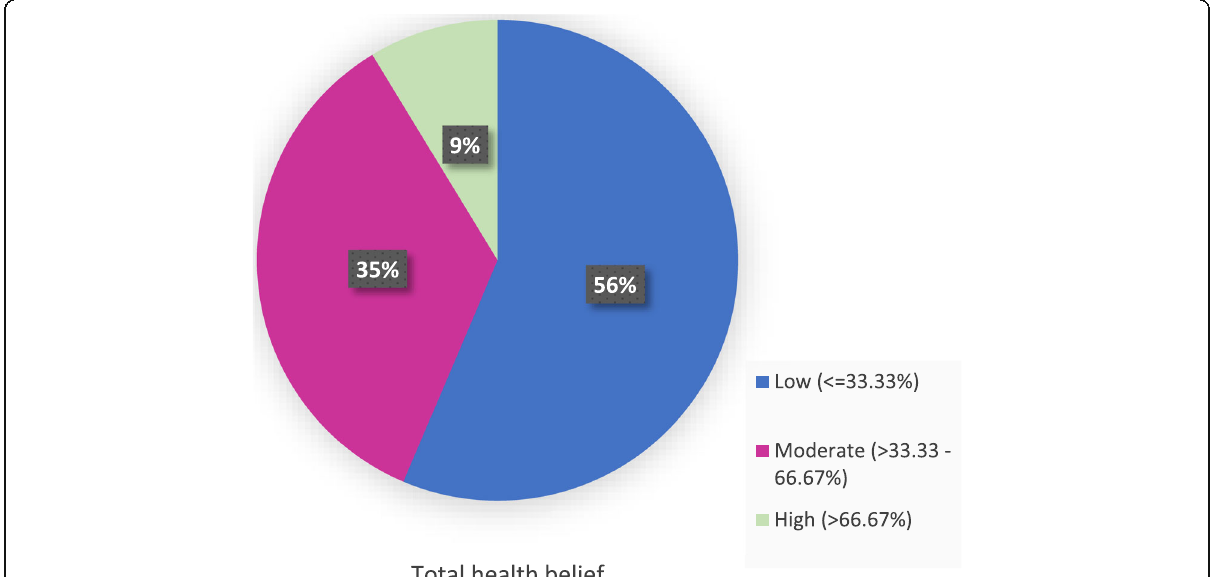
Fig. 4 Total health belief level of reproductive-age women in Alexandria regarding TTV and MNT,